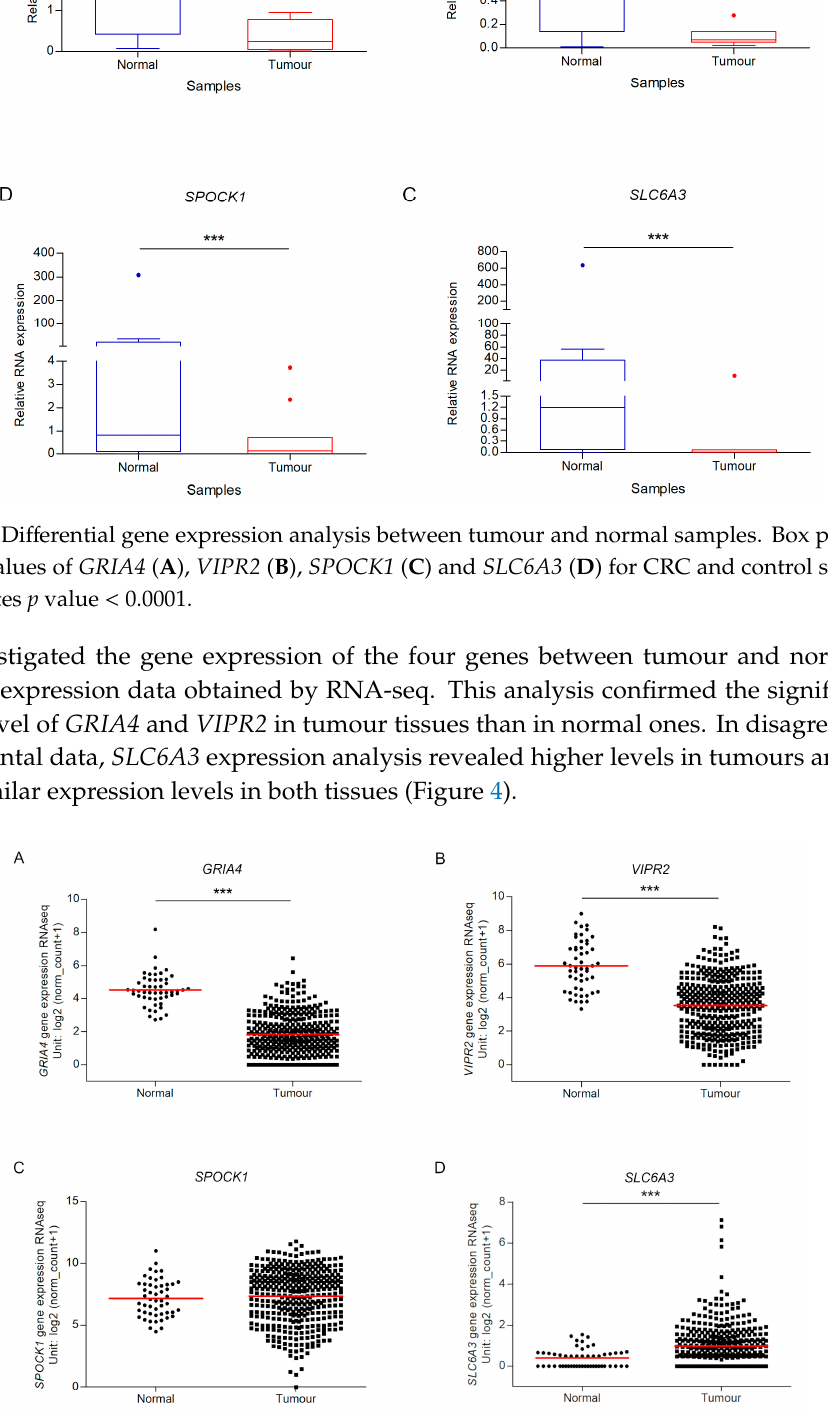
Figure 4. RNA expression of GRIA4 ( A ), VIPR2 ( B ), SPOCK1 ( C ) and SLC6A3 ( D ) in TCGA dataset. Tumour and normal expression of the four biomarkers. *** indicates p value <